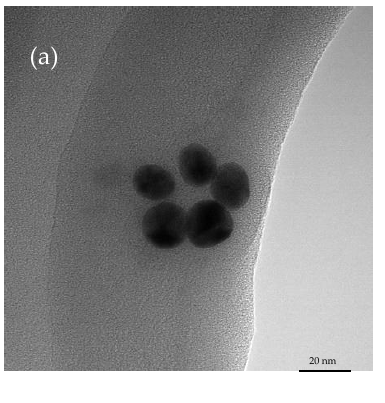
Figure 4. UV-Vis spectra of AuNPs colloid.